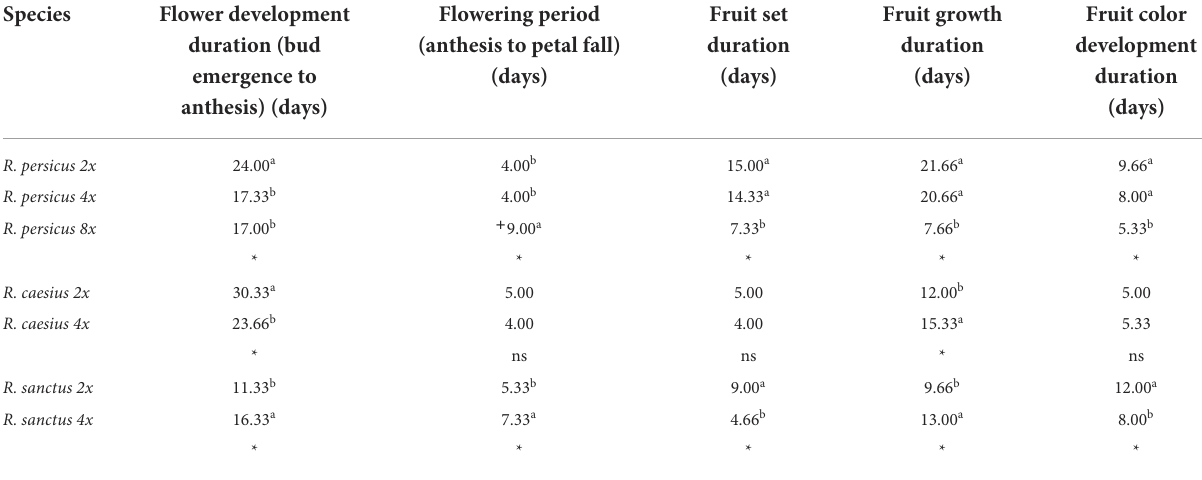
TABLE 1 Effect of ploidy level on phenological parameters of three Rubus species. Species Flower development